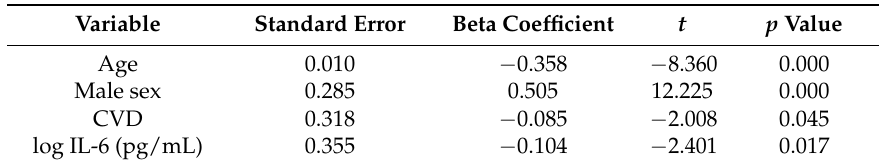
Table 2. Stepwise multivariate linear regression model identifying determinants of LTI. Abbreviations: CVD, cardiovascular disease; IL-6, interleukin-6; LTI, lean tissue